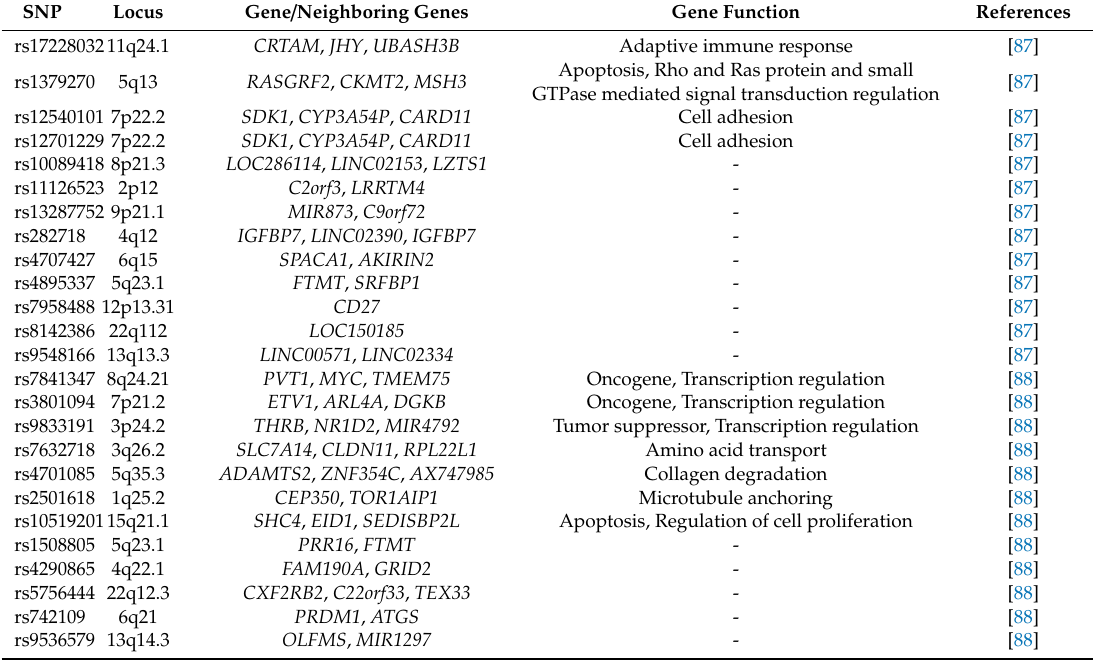
Table 2. The most significant single nucleotide polymorphisms (SNPs) associated with malignant mesothelioma, as identified through genome-wide association studies